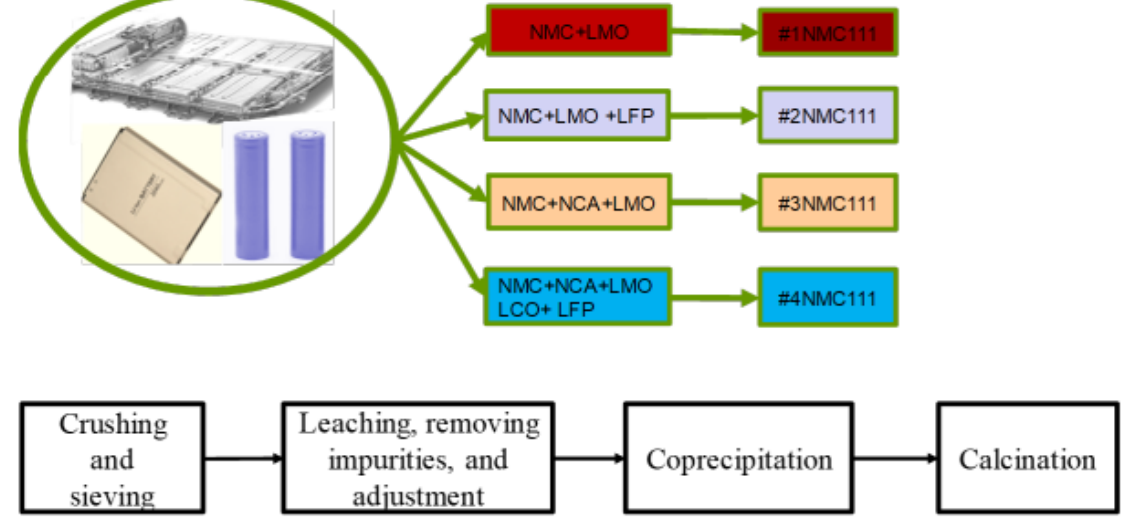
Figure 9. Schematic illustration of four various recycling streams, and the entire NCM111 regeneration process from spent LIBs. Reprinted with permission from Ref. [66], Copyright 2018, American Chemical